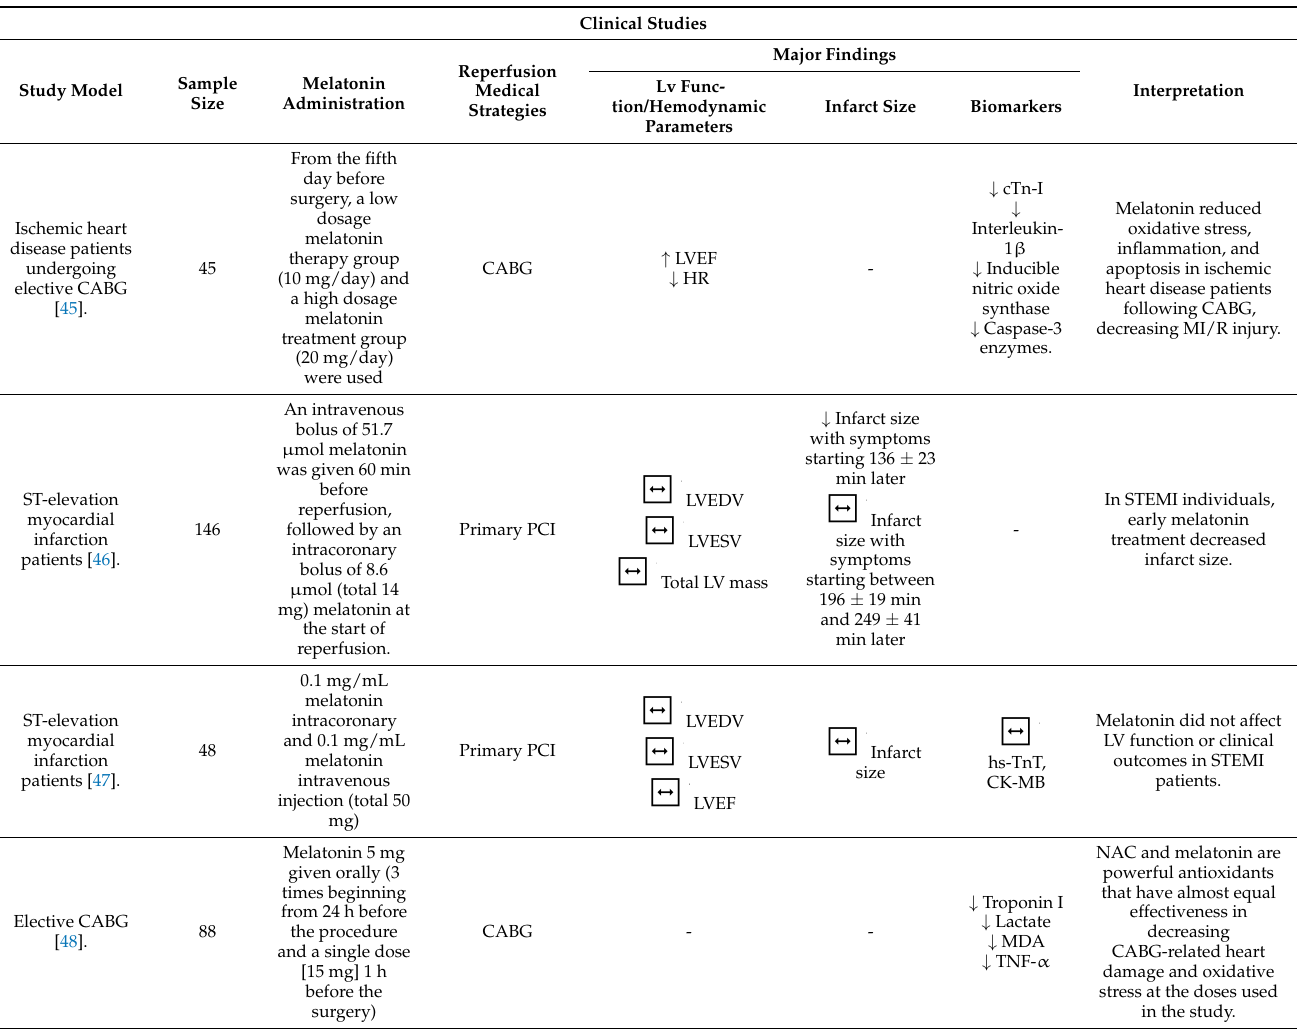
Melatonin did not affect LV function or clinical outcomes in STEMI hs-TnT, CK-MB